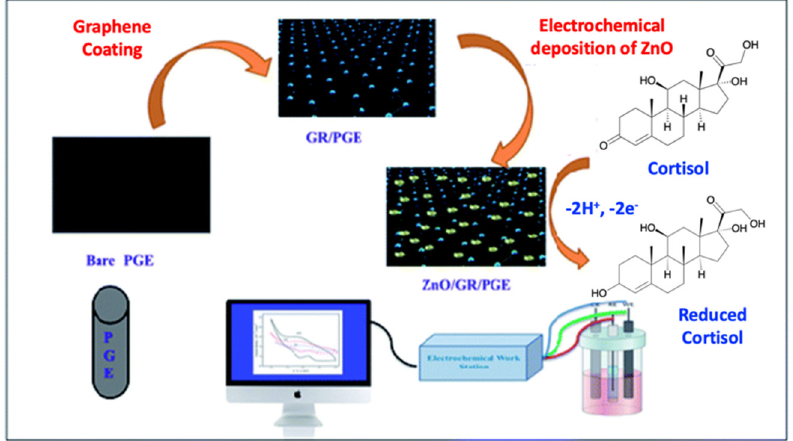
Figure 14. Schematic of the electrocatalytic determination of cortisol on ZnO nanoparticles deposited on a pencil graphite electrode (PGE) (adapted with permission from [74]. Copyright 2021 Royal Society of Chemistry).